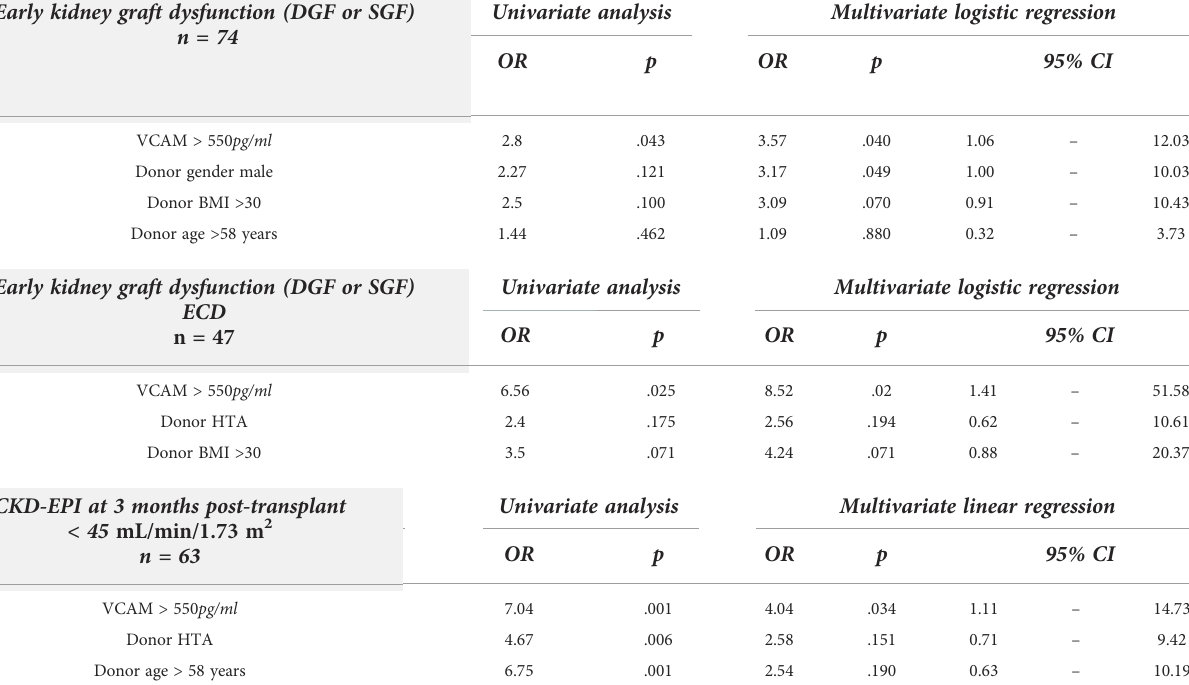
Early kidney graft dysfunction (DGF or SGF) n =